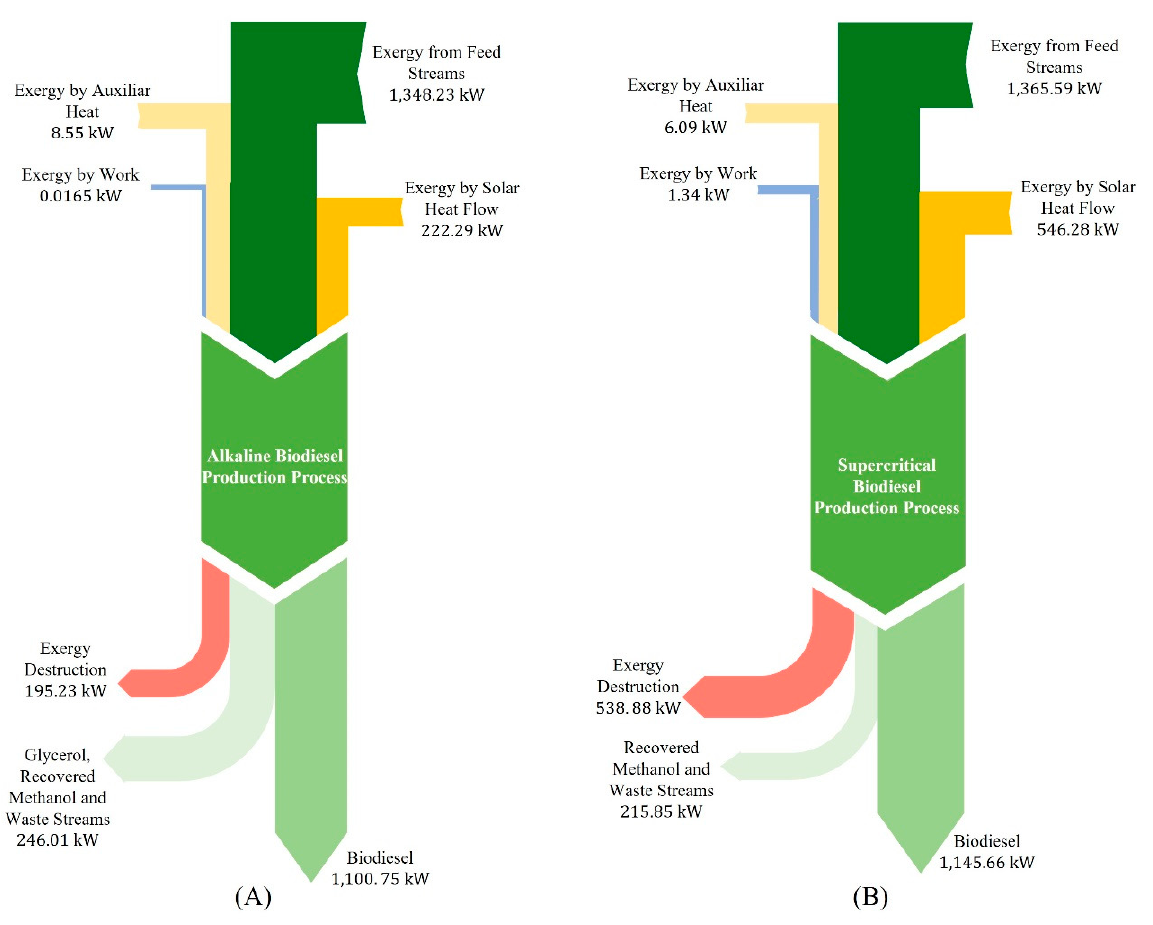
Figure 4. Sankey diagram of the global exergy balance for each process. ( A ) Alkaline process, ( B ) Supercritical process. Table 7. Exergy analysis